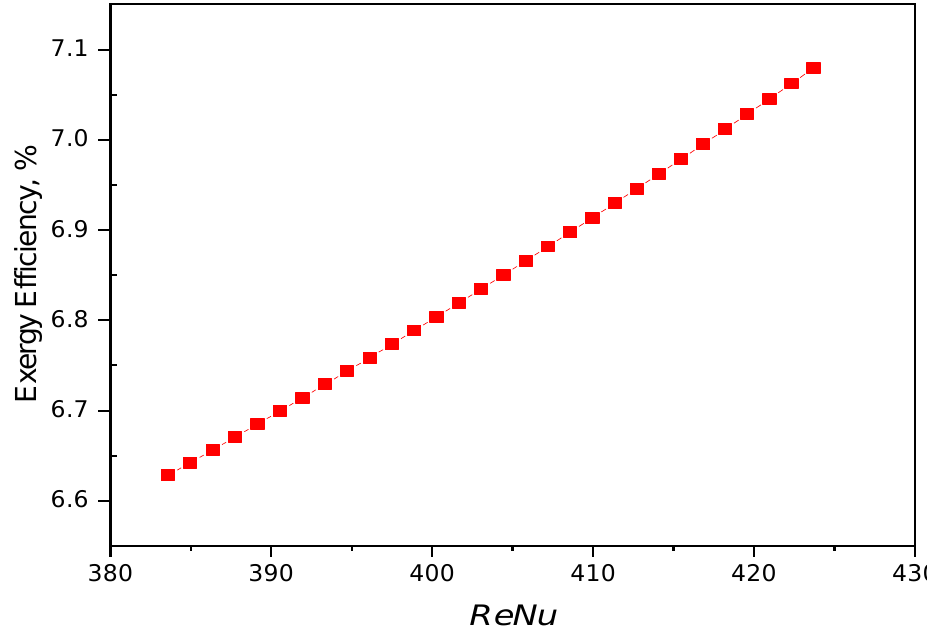
Figure 8. Correlation between non-dimensional parameters and exergy efficiency for CuO/water (flow rate = 1 L/min) nanofluid with different volume fraction of nanoparticles.